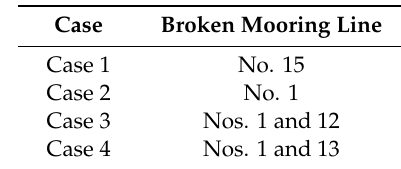
Table 8. Conditions of broken mooring lines.